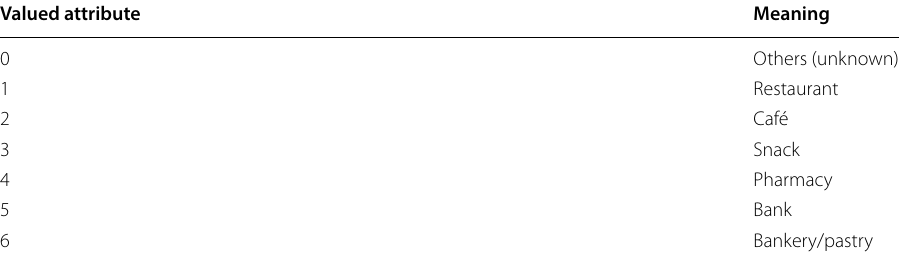
Table 6 Description of location values Valued